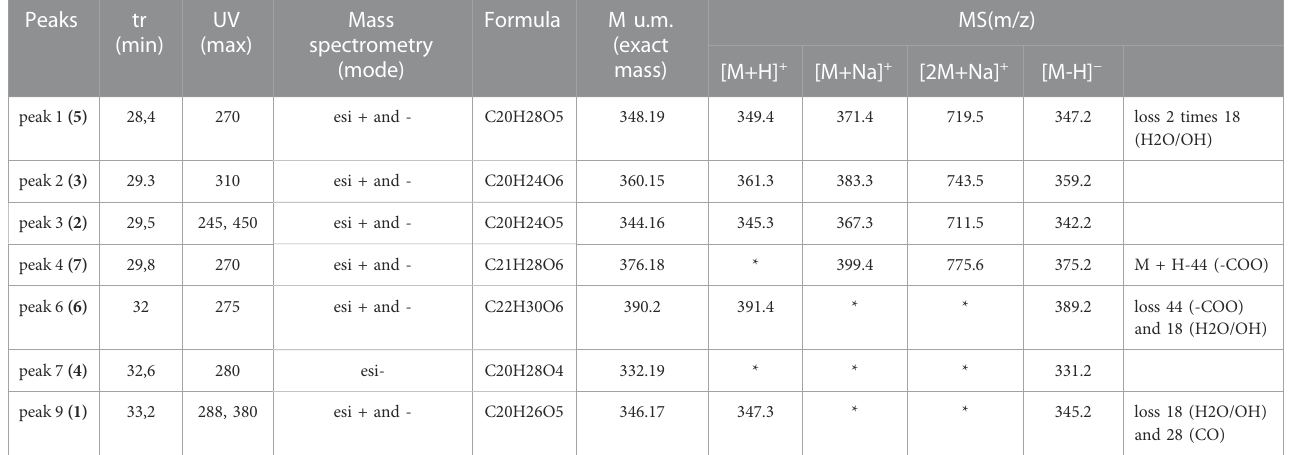
TABLE 1 Mass Spectrometry data for compounds (1) to (7) isolated from C. forsteri cyclohexane extract.